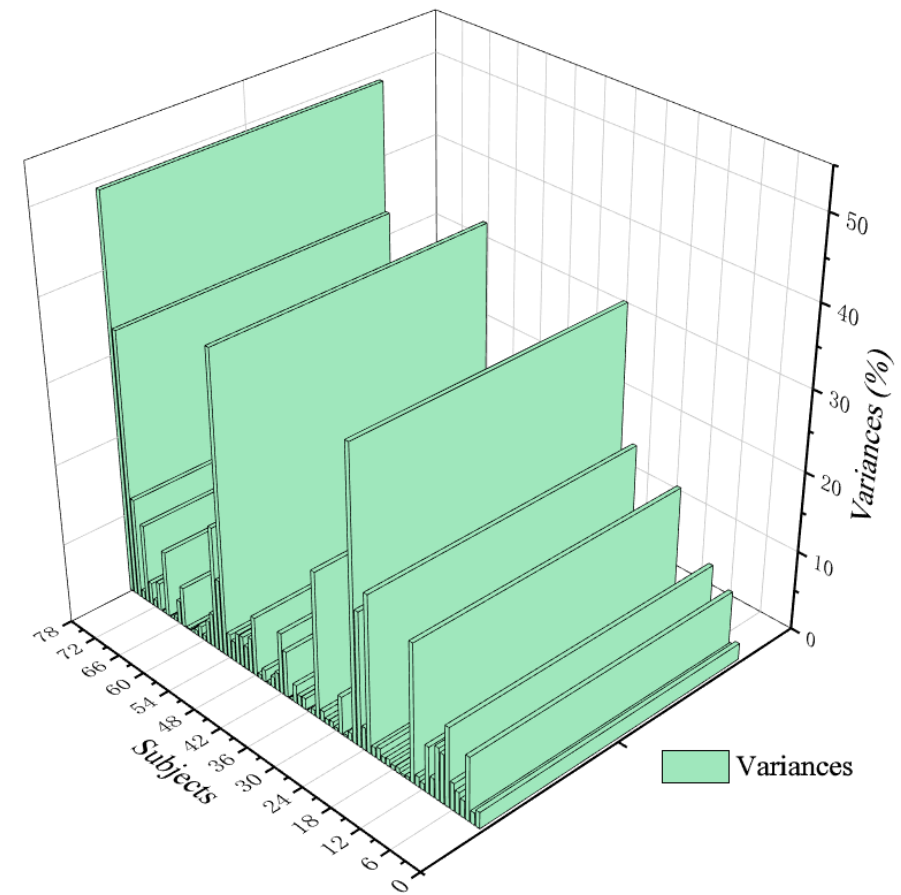
Figure 10. Variance trend plot of SC wave values. Source: ErgoLAB platform to export data, SC variance minimum 0, maximum value of 49%, average mean 5.594%.